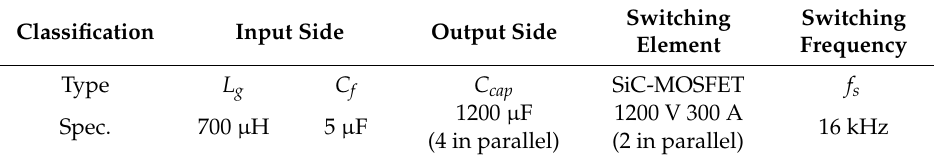
Table 1. Circuit design of the AC/DC power converter .